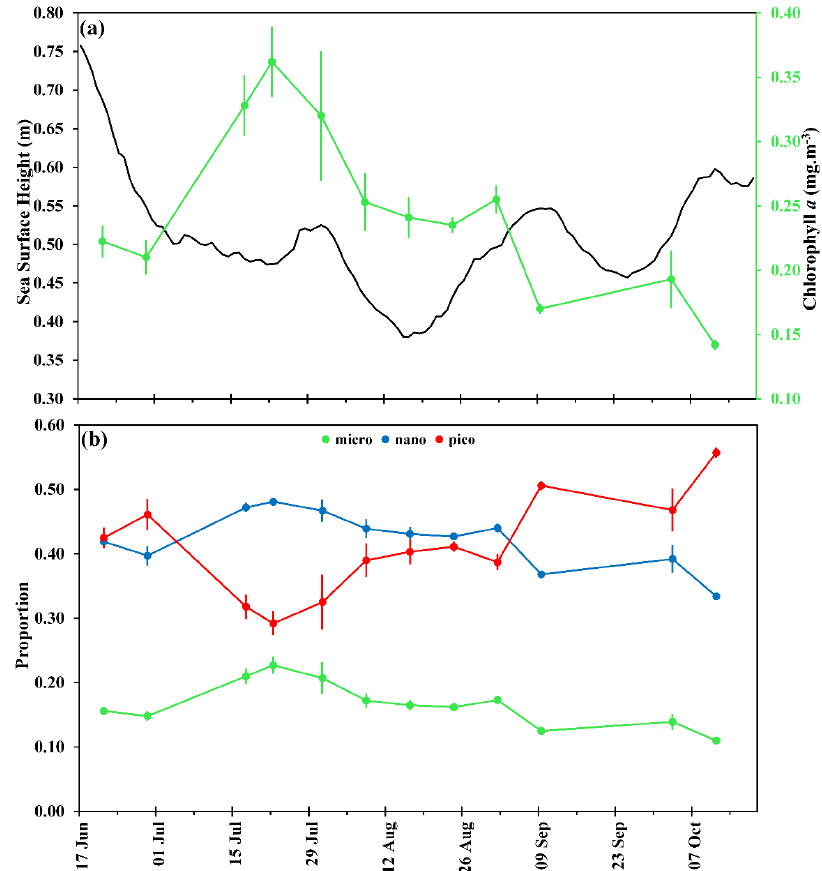
Figure 10. Temporal variation in ( a ) daily Sea Surface Height (SSH) (black line) and 8-day MODIS Aqua chlorophyll a (green line and dots), and ( b ) the fractional contribution of micro-, nano-, and picophytoplankton at the centre of the cyclonic eddy as it propagated across the Mozambique Basin. Vertical bars indicate the standard deviation of chlorophyll a and the fractional contributions of micro- (green dots and line), nano- (blue dots and line), and picophytoplankton (red dots and line) for the 3 × 3 pixel window at the centre of the eddy.